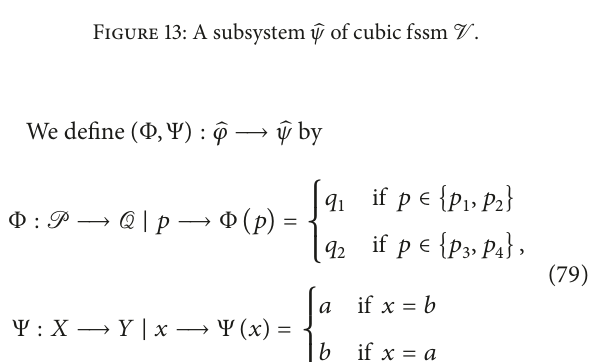
Figure 13: A subsystem ̂𝜓 of cubic fssm V